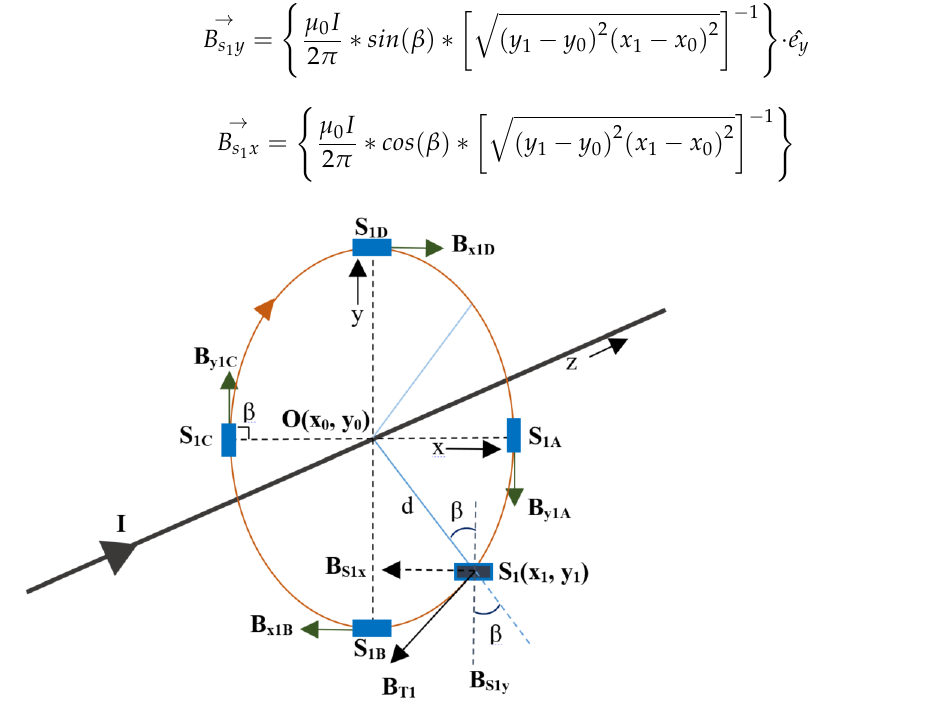
Figure 1. TMR sensor placed at various locations (depicted by solid rectangles) around a single- phase conductor. phase